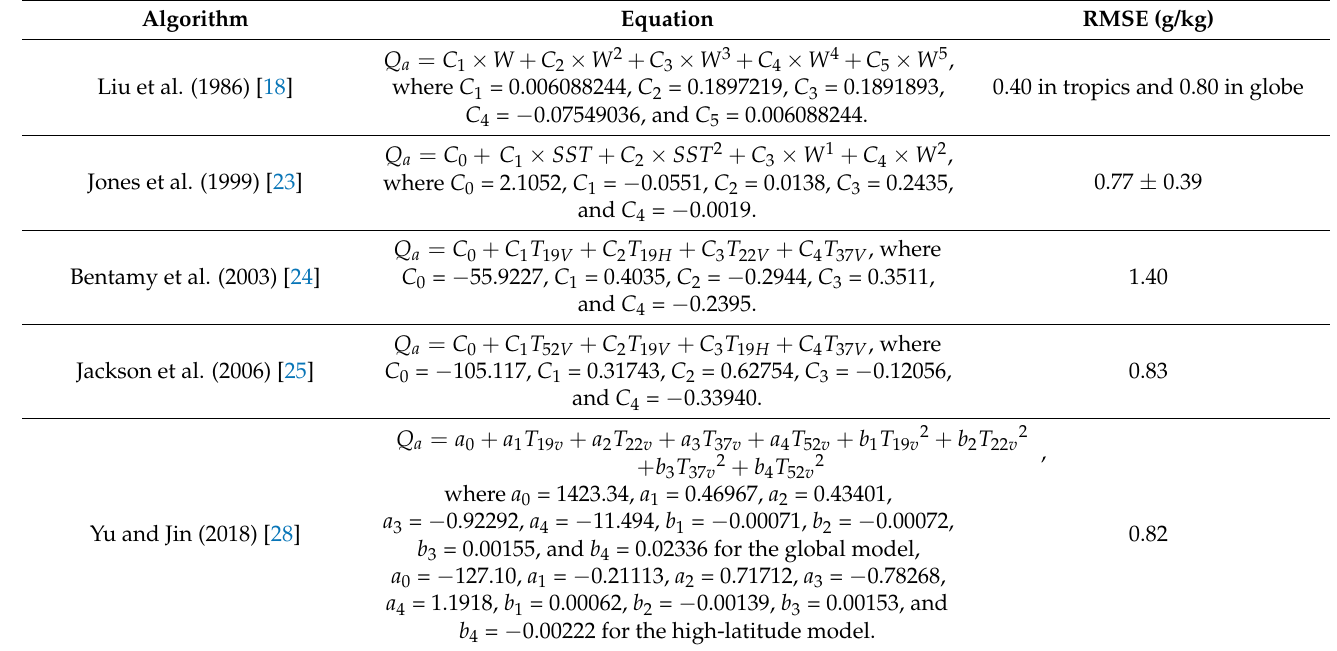
Table 2. Summary of the methods of surface humidity retrieval validated in this study. Here, the W denotes the parameter TPW in the main